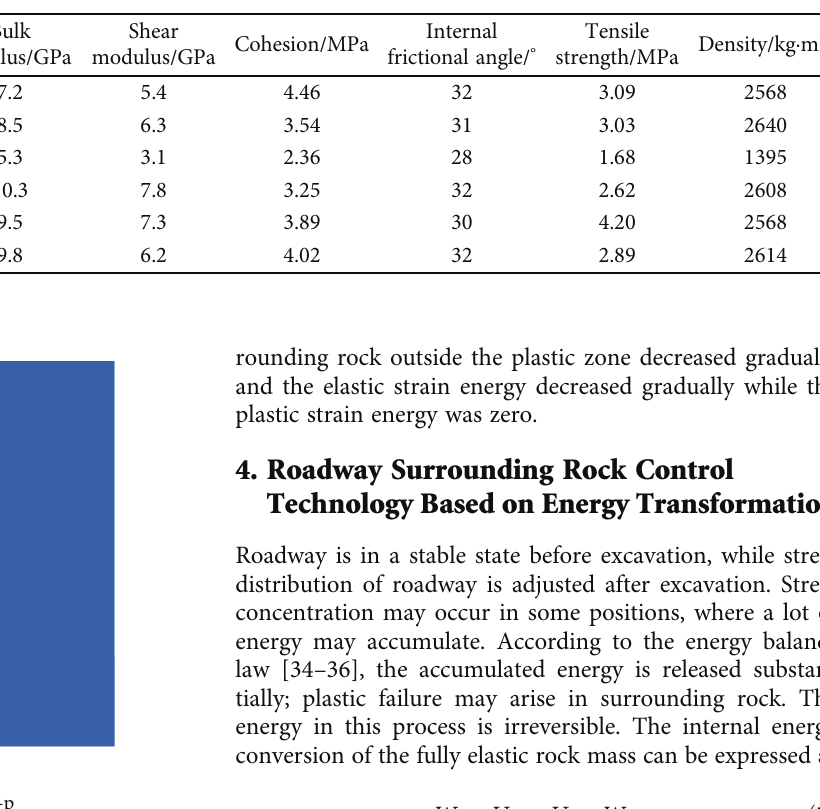
Table 1: Mechanical parameters of surrounding rock.